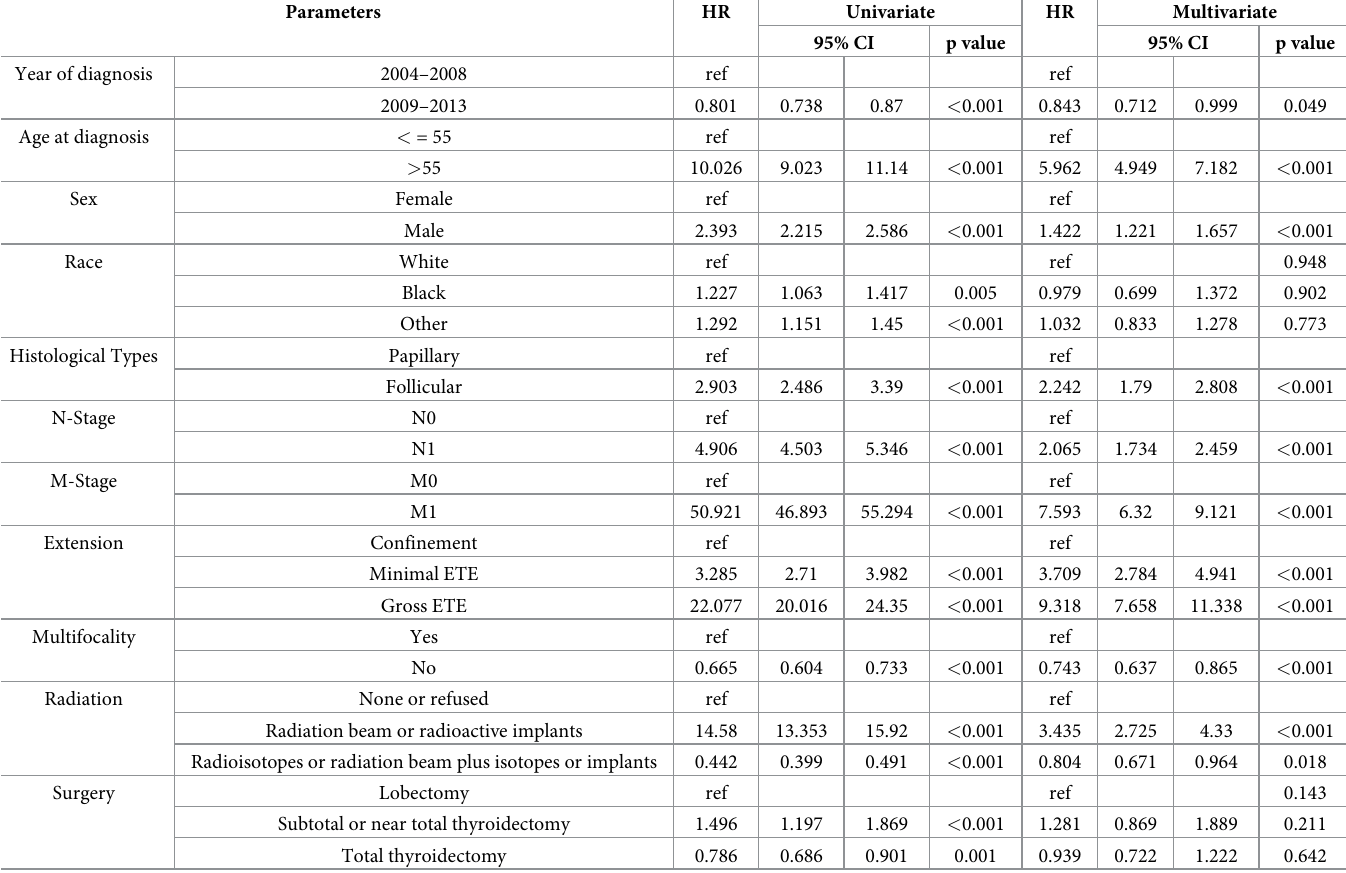
Table 4. Clinicopathologic parameters associated with the cancer-specific